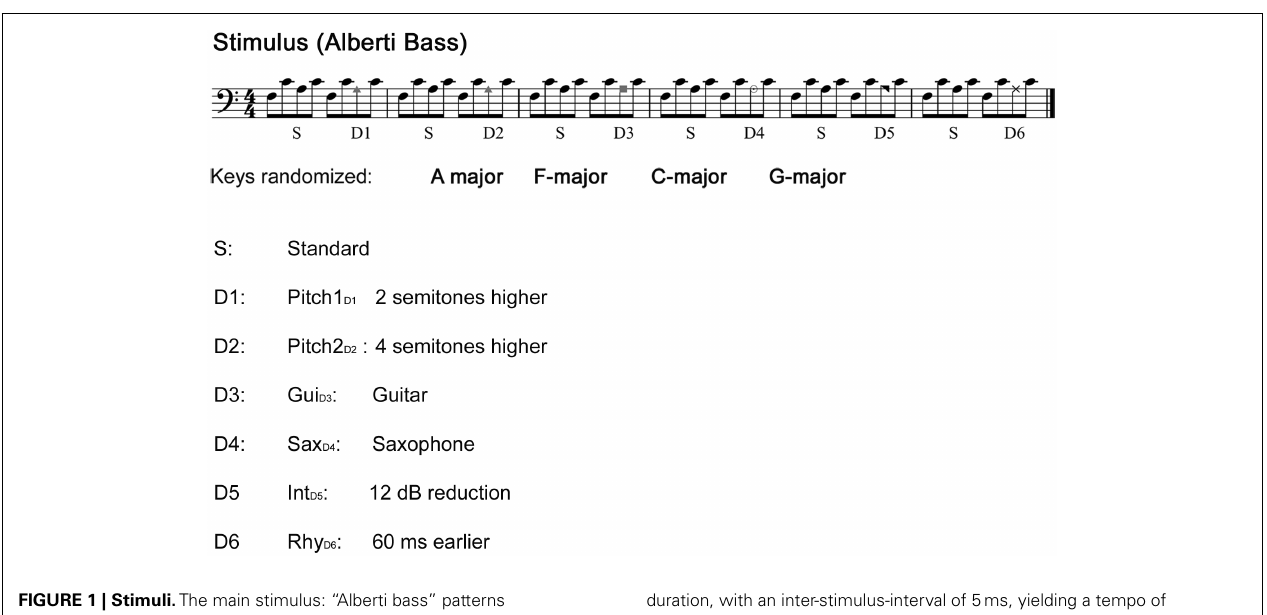
FIGURE 1 | Stimuli. The main stimulus: “Alberti bass” patterns alternating between standard sequence and a deviant sequence played with a piano sound. Patterns were periodically transposed to four different keys with an interval of six bars. Each tone was 200ms in